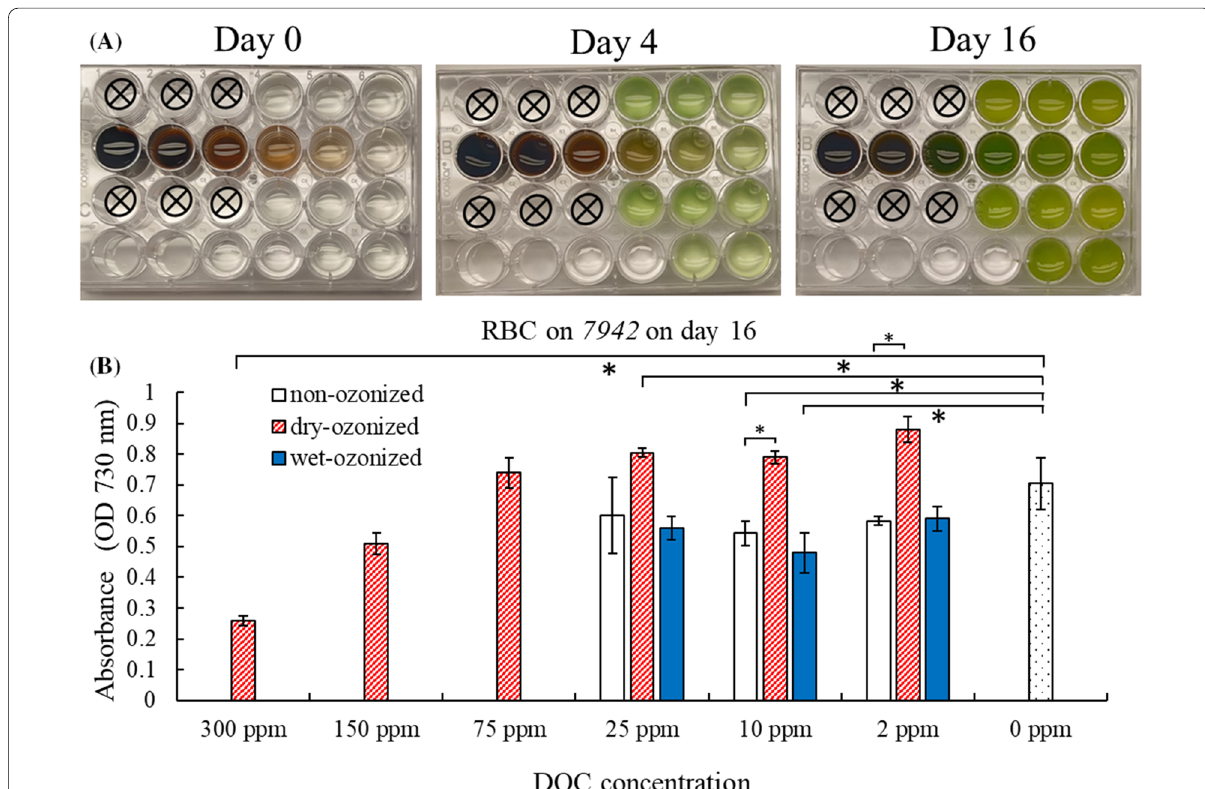
Fig. 5 Growth assay of Synechococcus elongatus PCC 7942 (7942) in incubation with filtrates from wet-ozonized, dry-ozonized, and non-ozonized rogue biochar (RBC) at different DOC concentrations. A Photographs of multi-well plate with RBC biochar filtrates inoculated with 7942 on day 0, day 4 and day 16 of the growth assay. The photographs shown are one of the two replicates. The setup of the plate is shown in Table 1. B Optical density (OD730) of 7942 after 16 days of incubation with RBC filtrates. The error bars on the graph represent the standard deviation of the 2 multi-well plates ( n 2). The asterisks brackets (*) show significant difference ( p < 0.05) between =